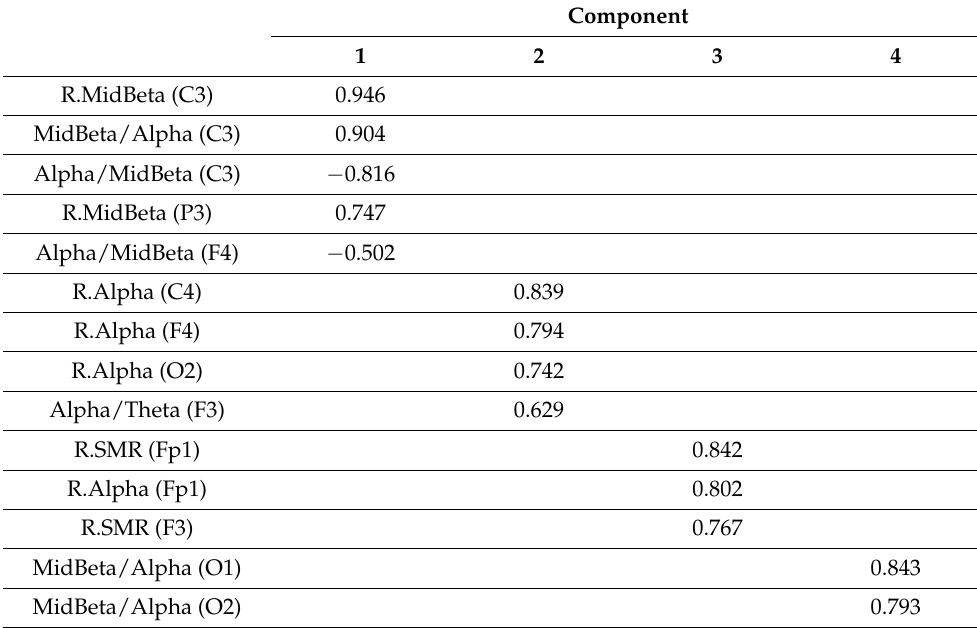
Table 3. Components and eigenvalues of 15